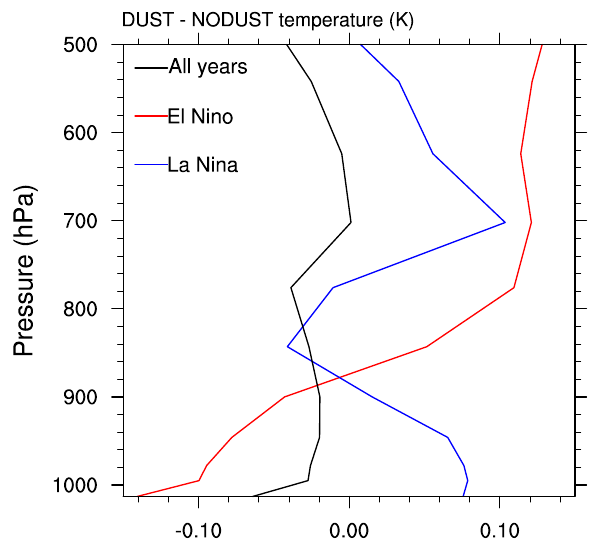
Fig. 15. As Fig. 14, but showing profiles of dust-induced temper- ature changes (difference between the DUST and NODUST runs). The dust-induced SST change is plotted at